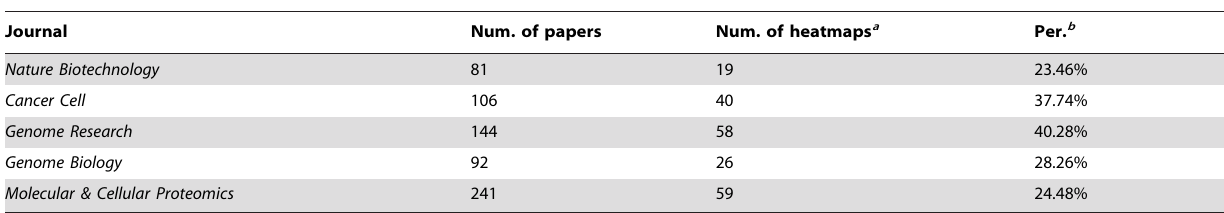
Table 1. Using frequency of heatmap.